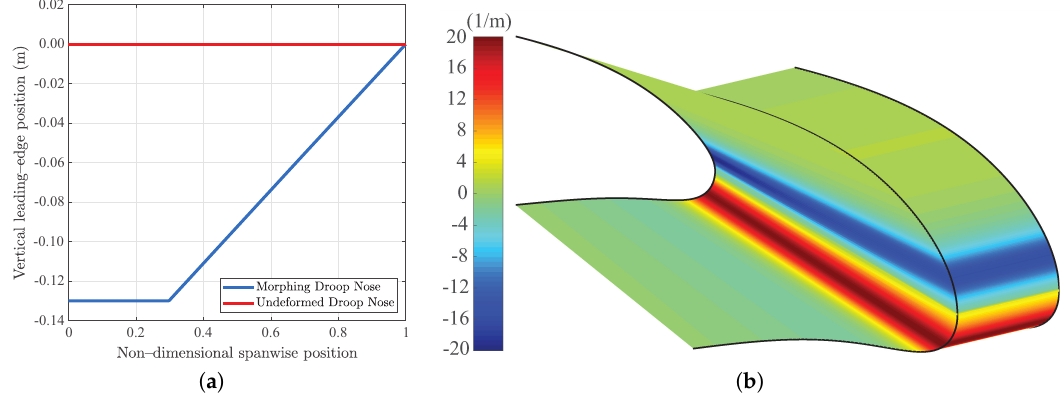
Figure 9. Vertical leading-edge position parameter ( a ), and corresponding morphing Class/Shape function Transformation (CST) shape and skin curvature variation ( b